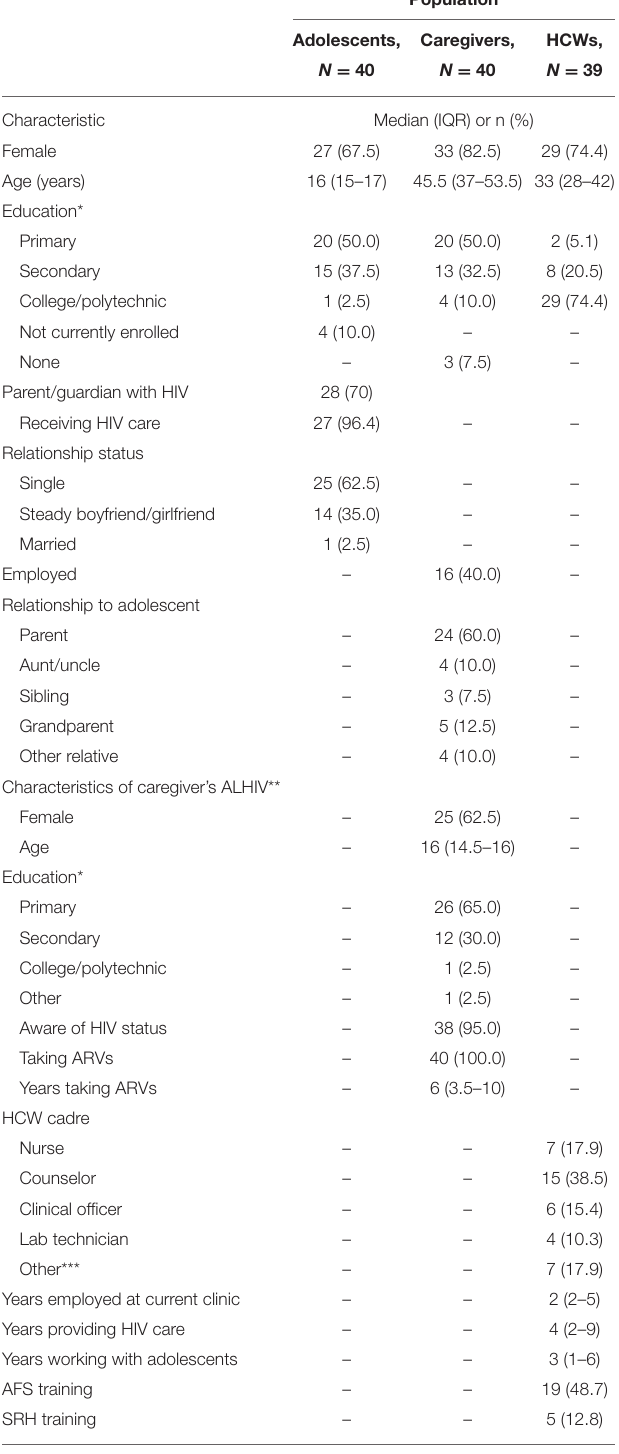
TABLE 2 | Sociodemographic characteristics of FGD and IDI participants.